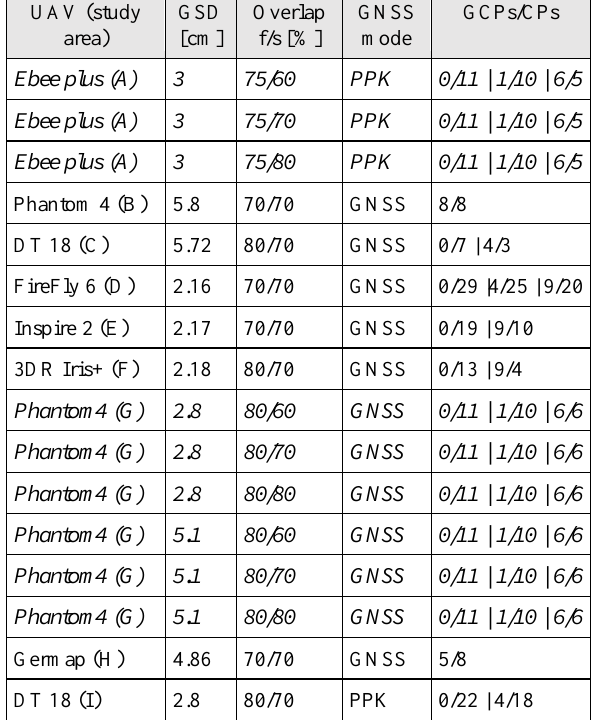
Table 2: UAV flight mission parameters. Italic font indicates controlled test flights i), normal font indicates additional